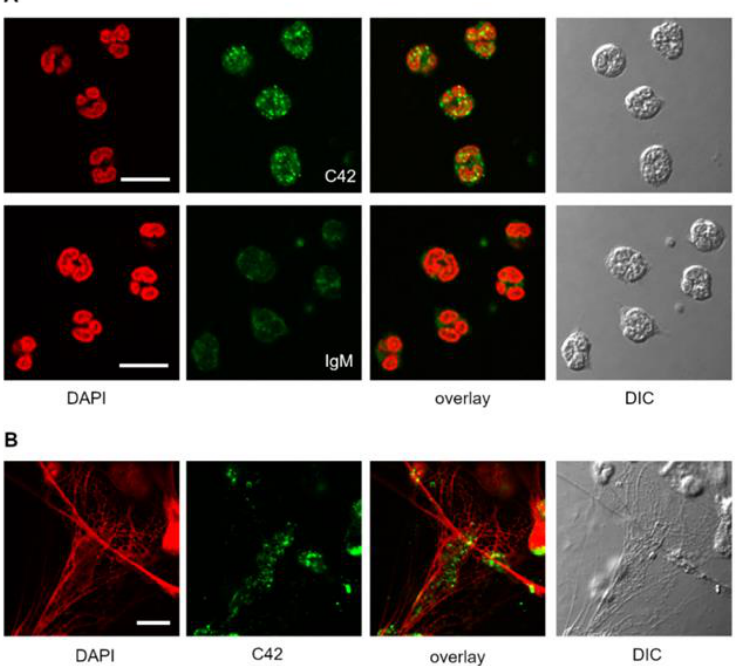
Figure 4. Localization of the C36 peptide of AAT in human neutrophils. ( A ) C36-positive signal ( green ) was observed in granular-like structures throughout the cells. Lack of the signal in the isotype control with non-reactive IgM (lower raw) confirmed specificity of the C42 mAb. ( B ) C36-immunoreactivity ( green , stained with C42 mAb) was detected in extracellular traps (NETs) structures, albeit without co-localization with DNA fibers ( red ). Nuclei and DNA fibers were defined by 4′,6-diamidino-2-phenylindole (DAPI, red ). Scale bar, 10 µm.